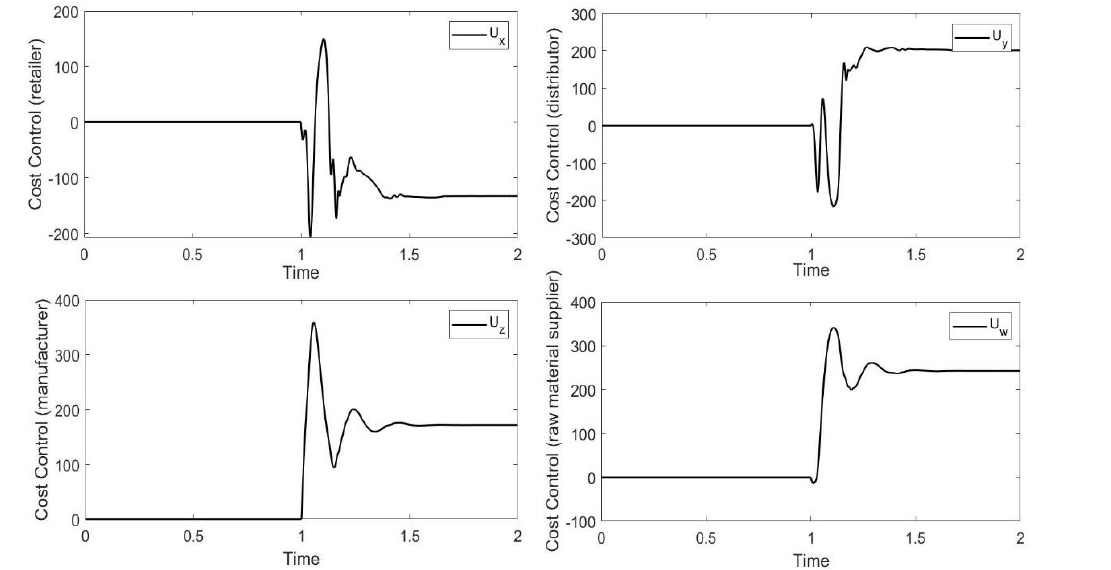
Fig. 8. Control cost for synchronization of hyperchaos supply chain (or controller